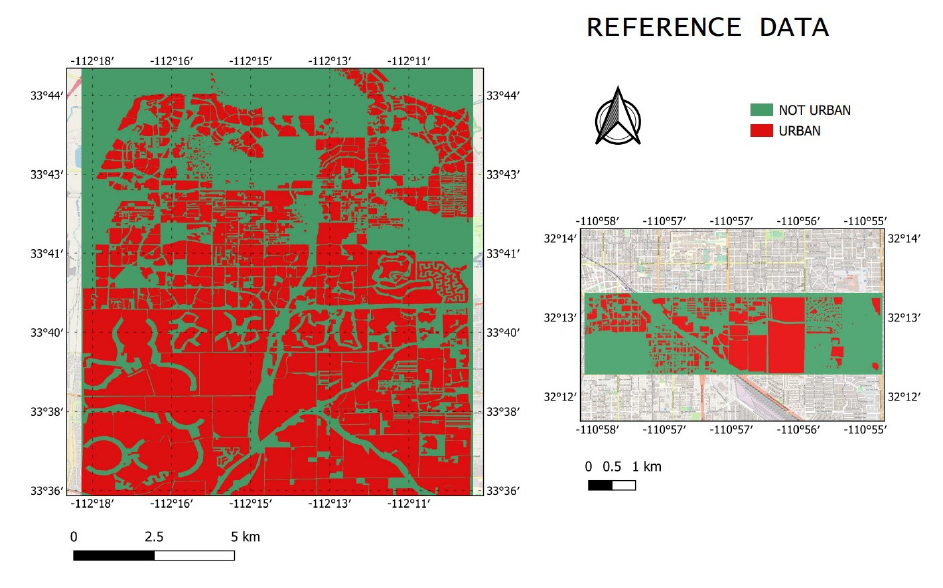
Figure 5. Reference data manually collected over Phoenix and Tucson. High-resolution images have been interpreted visually.